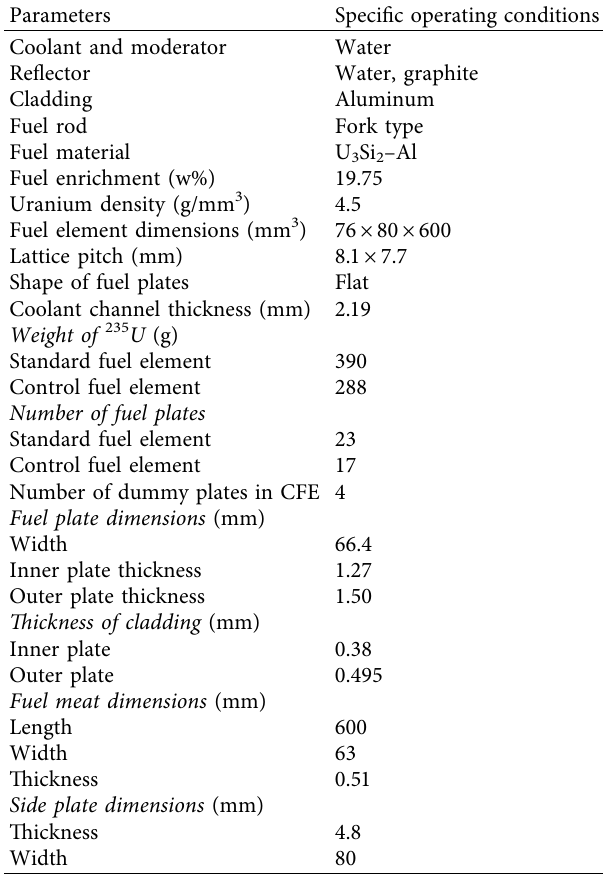
Table 2: Main operating conditions for